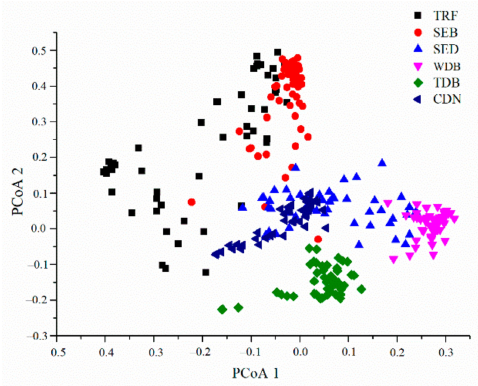
Figure 3. Principle coordinates analysis (PCoA) illustrating patterns of soil fungal communities grouped by di ff erent forest